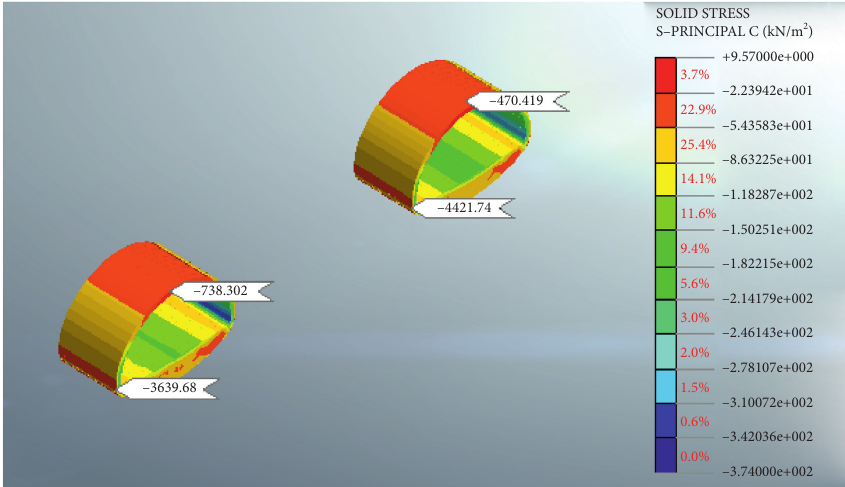
Figure 23: Second lining stress distribution of single-side guide pit method.